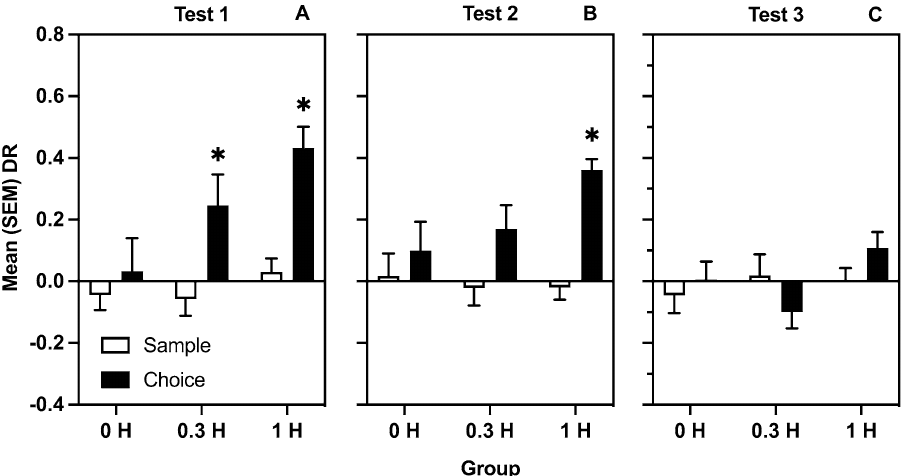
Figure 2. Effects of injected heroin and exposure to context CS on object location memory. ( A ) mean (SEM) DRs from sample and choice phases of 0, 0.3, and 1 mg/kg groups on the test of memory modulation by the last conditioning session. ( B ) mean (SEM) DRs from sample and choice phases on the test of memory modulation by the first extinction session. ( C ) mean (SEM) DRs from sample and choice phases on the test of memory modulation by the last extinction session. The * indicates a significant difference between